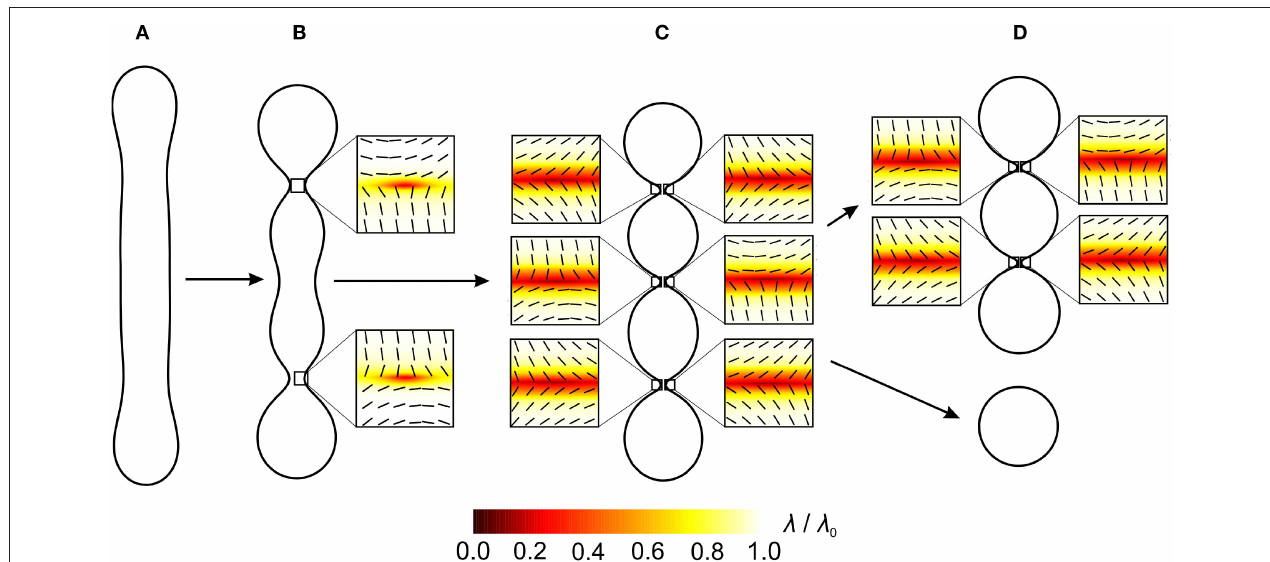
FIGURE 3 | Necklace-like buds/endovesicles with topological antidefects in their necks. The sequence demonstrates the transformation from the shape without a prominent neck (A) through the intermediate shape (B) to the shape with three prominent thin necks (C) . Finally, the neck rupture results in the formation of two distinct membranes (D) . The positions of antidefects are marked by small squares. Orientational ordering profiles with the superimposed nematic director fields in the vicinity of topological antidefects are magnified. R /ξ 21, where R represents a typical linear dimension of a shape and ξ the nematic order correlation length defined = in section